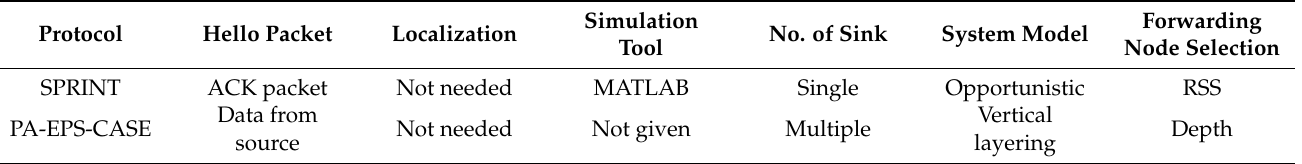
Table 3. Comparison Proactive routing